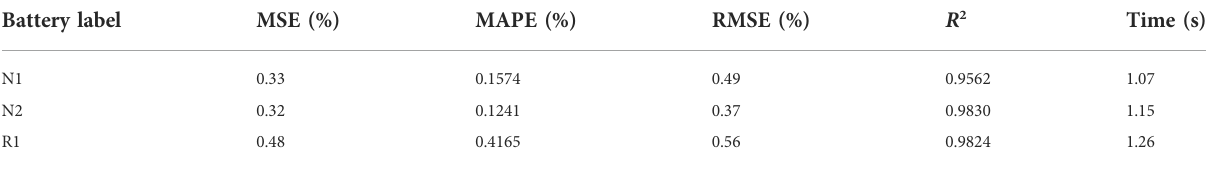
TABLE 4 The statistical errors of SOH estimation results. Battery